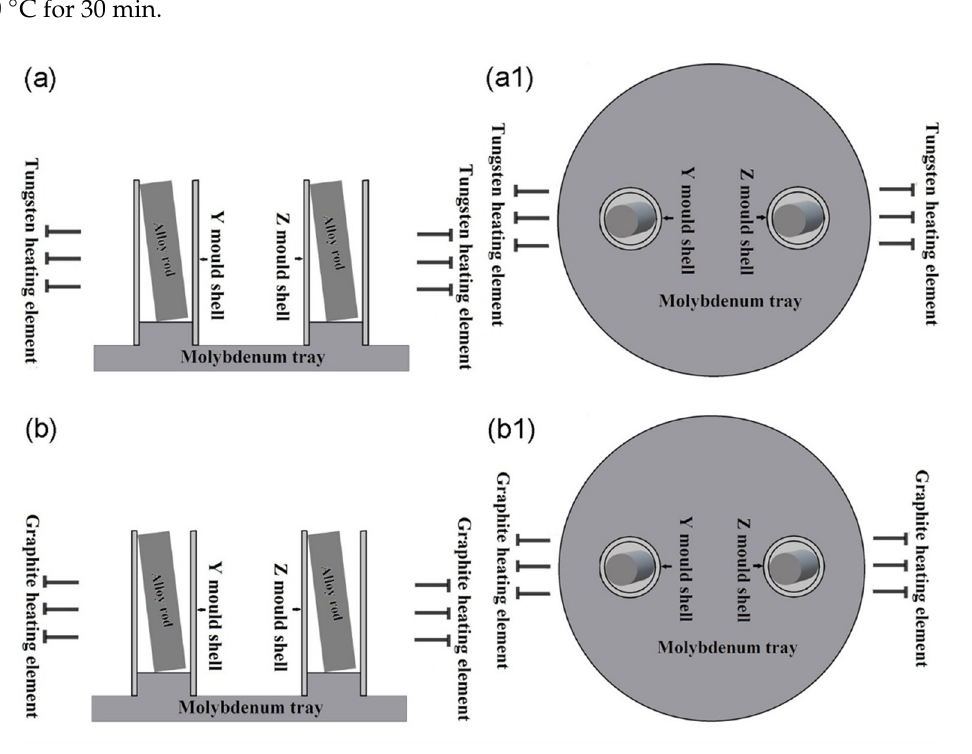
Figure 1. Schematic drawing of the assemblies with Y and Z mold shells for re-melting the alloy: ( a ) front view and ( a1 ) top view of the assembly in the furnace with the tungsten heating element and ( b ) front view and ( b1 ) top view of the assembly in the furnace with the graphite heating element.